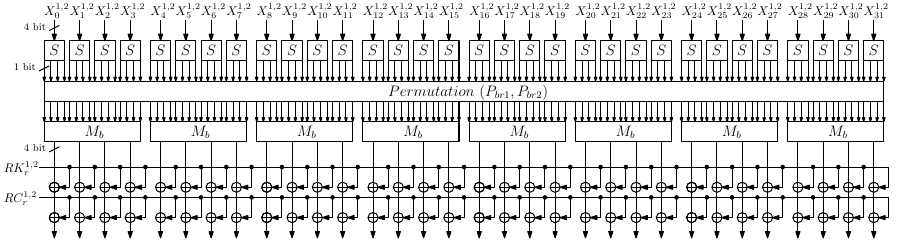
Figure 3: The round function of Branch1 and Branch2 in the first 4 rounds.